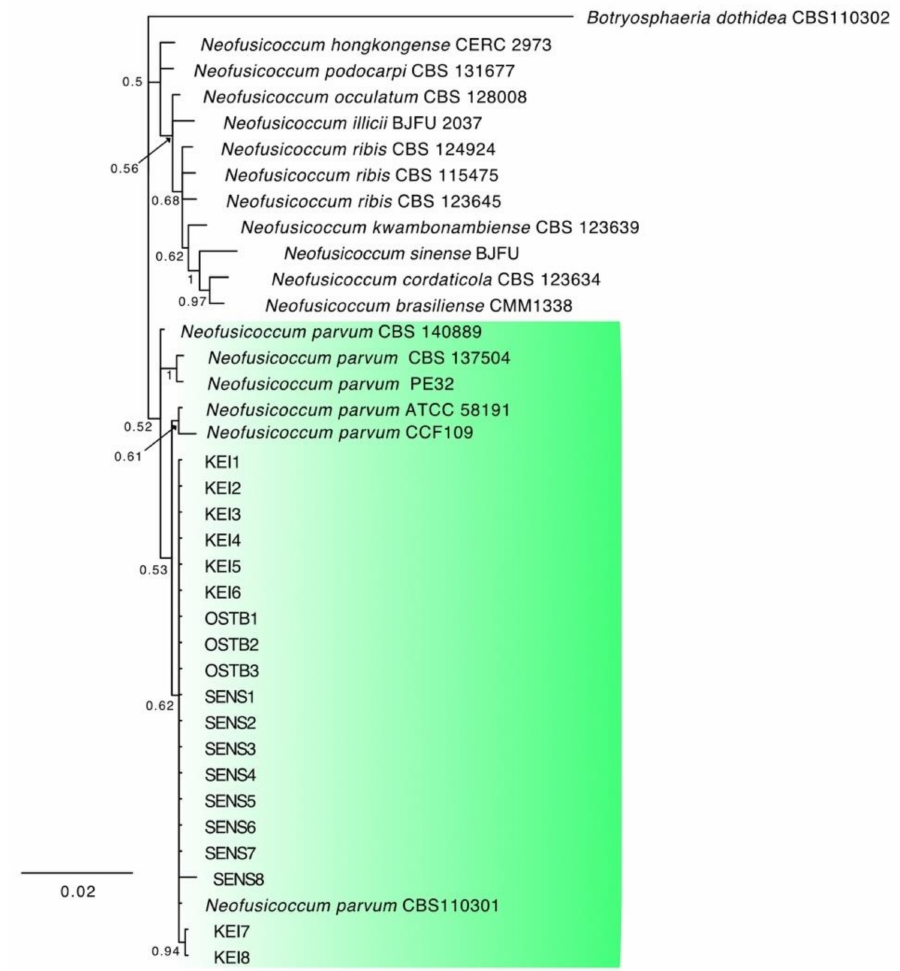
Figure 6. Consensus phylogram of 6392 trees resulting from a Bayesian analysis of the combined ITS, tef1 , and tub2 sequence of Neofusicoccum species. The tree was rooted to Botryosphaeria dothidea (CBS110302). Bayesian posterior probability values are indicated at the nodes. The cluster containing the isolates obtained in this study is highlighted in